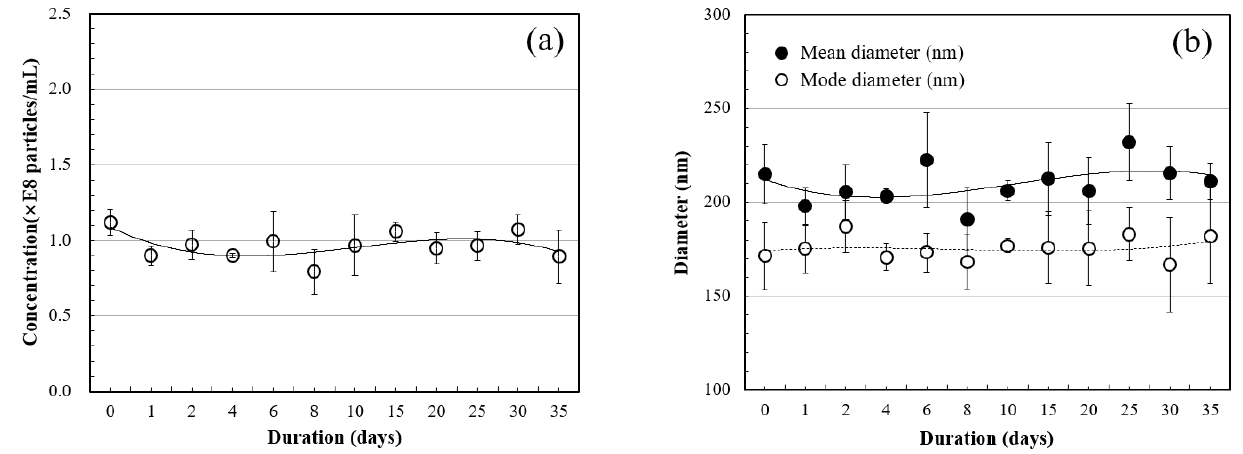
Figure 3. NTA test results: ( a ) average particle concentration of nanobubbles; ( b ) average mean and mode diameter of nanobubbles.